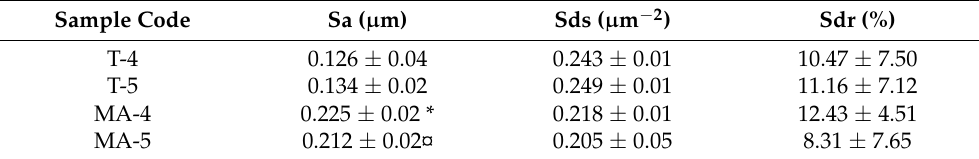
Table 1. Surface parameters of turned grade 4 ( T-4 ), turned grade 5 ( T-5 ), mildly acid-etched grade 4 ( MA-4 ), and mildly acid-etched grade 5 ( MA-5 ) Ti surfaces. Data are expressed as mean ± standard deviation. N = 9/group; * = p < 0.05 vs. T-4; ¤ = p < 0.05 vs. T-5. Sa: absolute deviation of the surface;